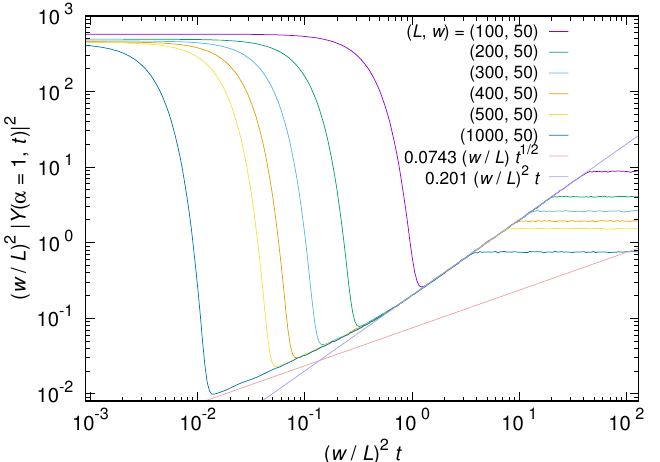
Figure 26 . ( w=L ) 2 j Y ( (cid:11) = 1 ; t ) j 2 vs ( w=L ) 2 (cid:1) t , L = 100 ; 200 ; 300 ; 400 ; 500 ; 1000, w = 50, (cid:11) = 1. 10000 samples have been taken.